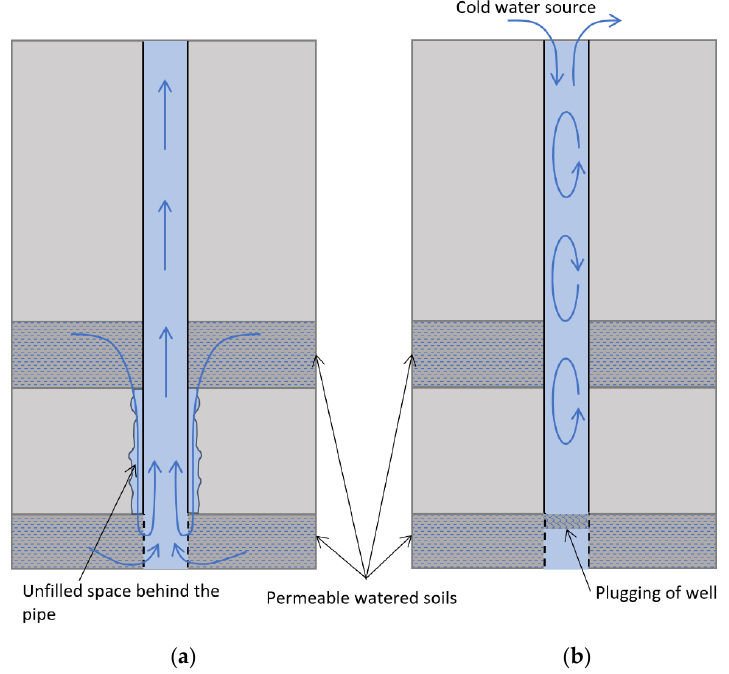
Figure 6. Schemes of convective flows of water in a well in the framework of the first ( a ) and second ( b ) hypotheses.